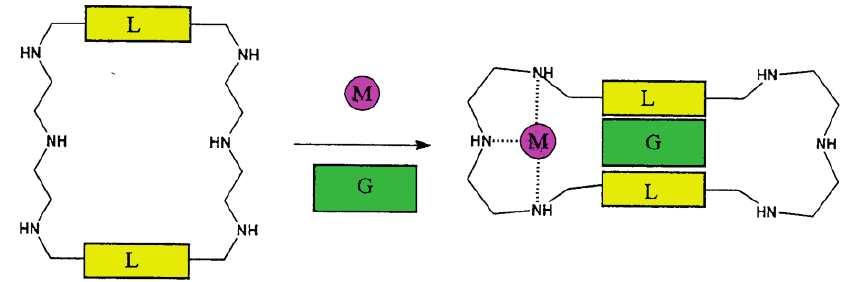
Figure 9. An example of an allosteric system (L = p -phenyl, M = Zn 2+ , G =